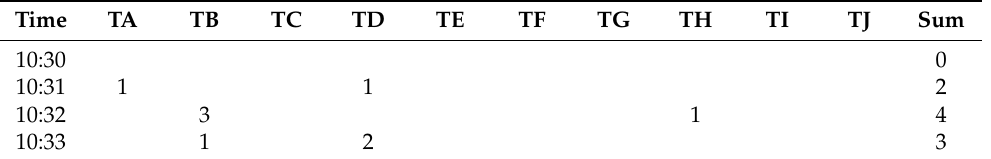
Table 3. Sample data collected at workplace B during the observation of 1